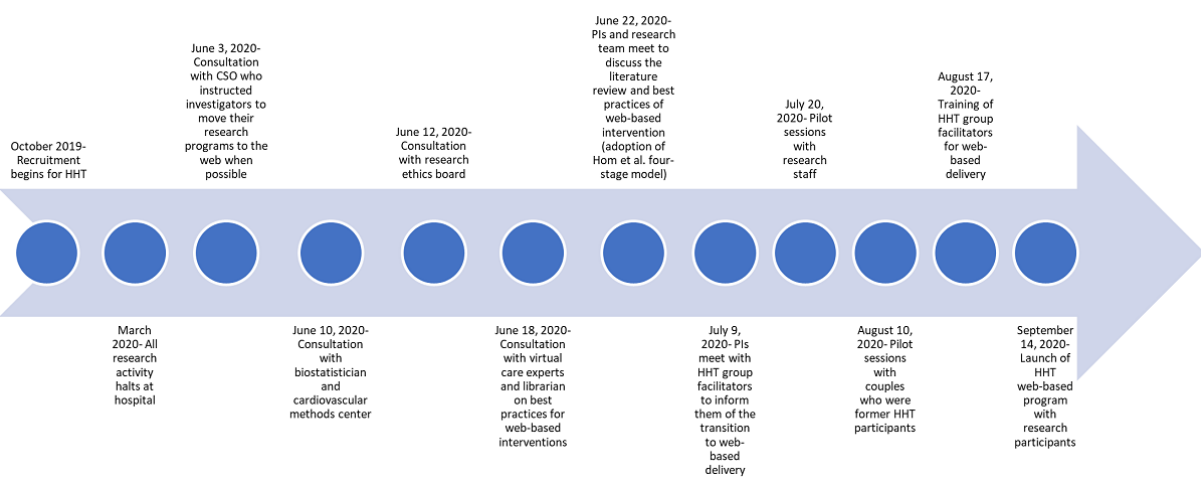
Figure 1. Timeline of the transition to a web-based intervention during COVID-19. CSO: chief scientific officer; HHT: Healing Hearts Together; PI: principal